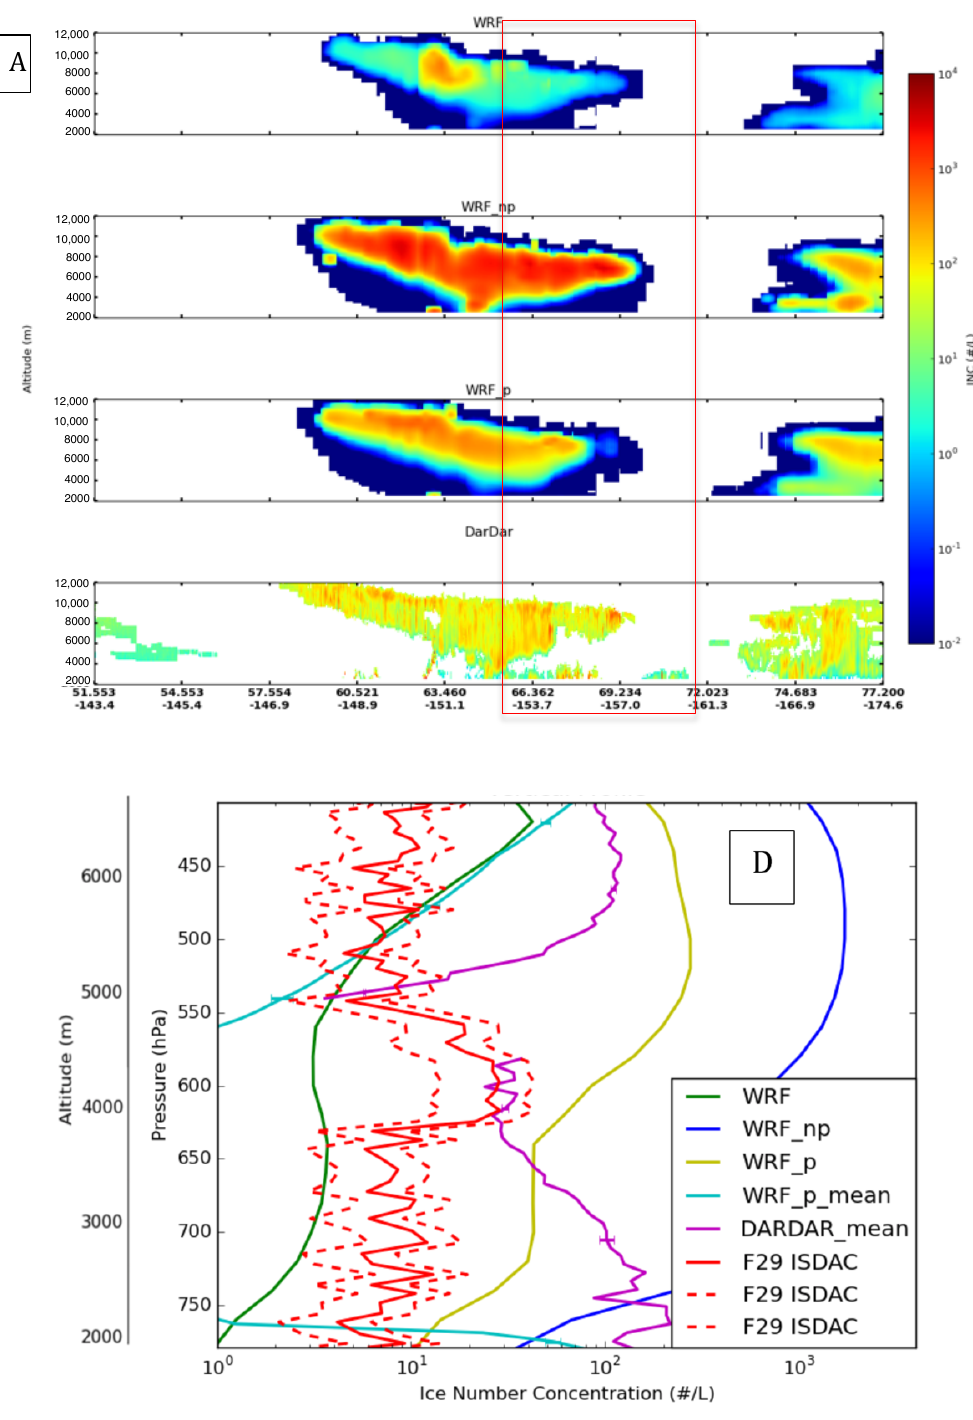
Figure 13. Observed and simulated (WRF, WRF_np and WRF_p) Ni along T29 track ( A ) and F29 flight ( B ). Simulated profile WRF_p_mean averaged along the satellite track over the larger domain of Figure 1 is also shown on ( B ) together with DARDAR-retrieved average profile. The dashed red line on ( B ) represents the variability (standard deviation) of ISDAC